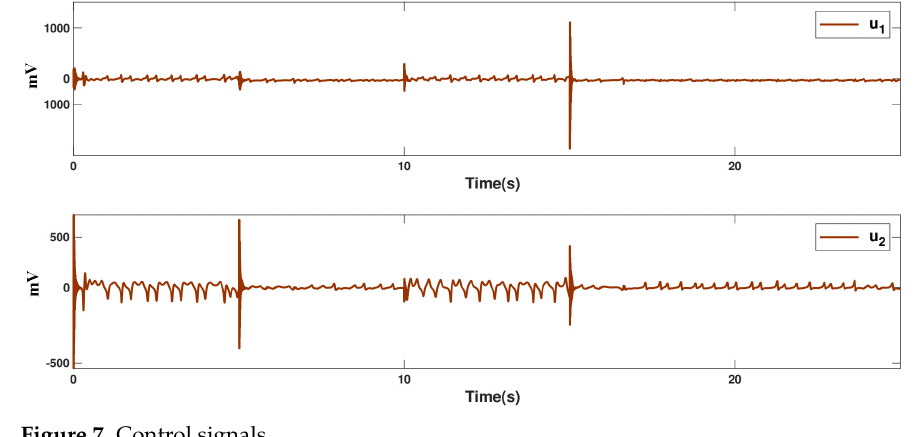
Figure 7. Control signals.